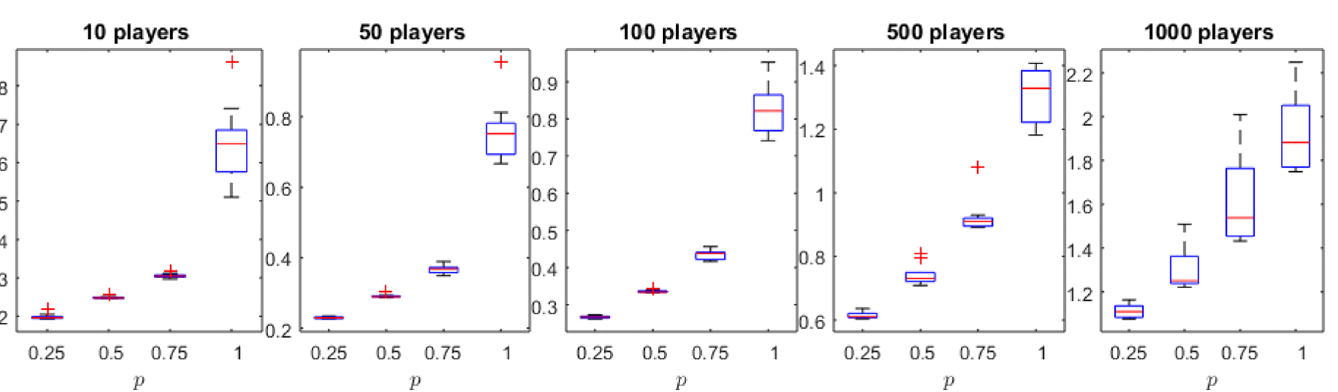
PLOS ONE | https://doi.org/10.1371/journal.pone.0174963 May 3,